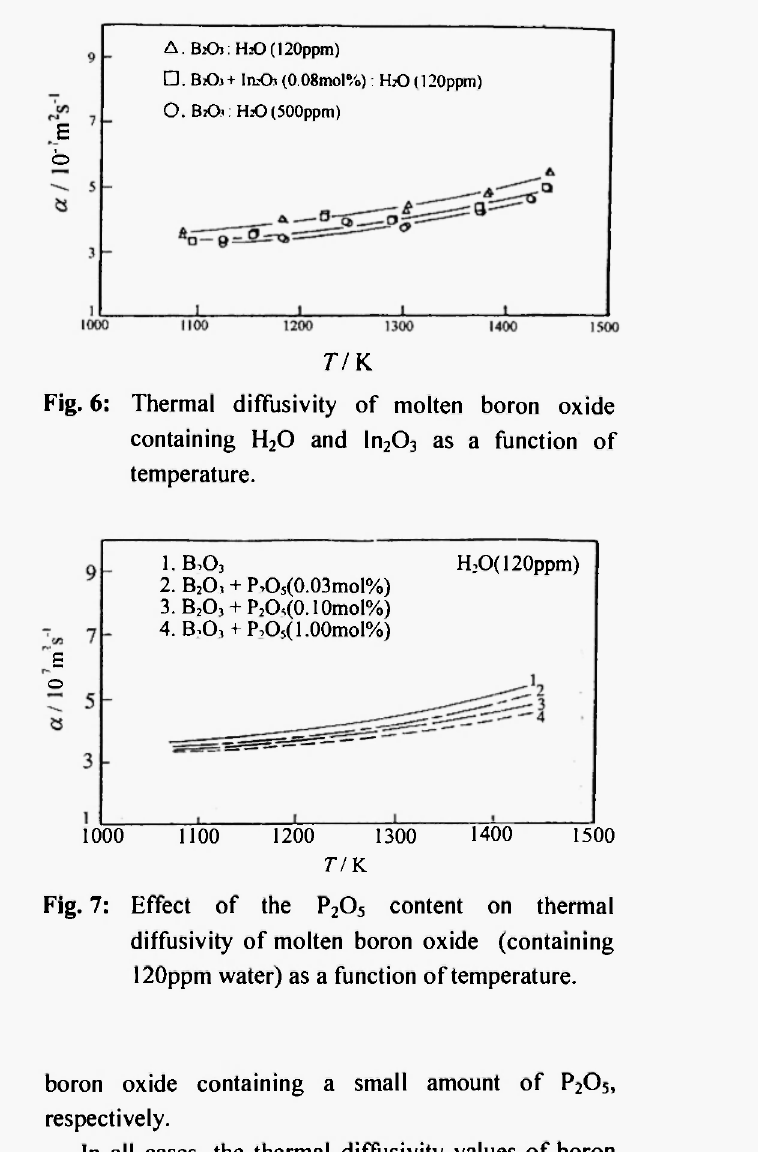
boron oxide containing a small amount of